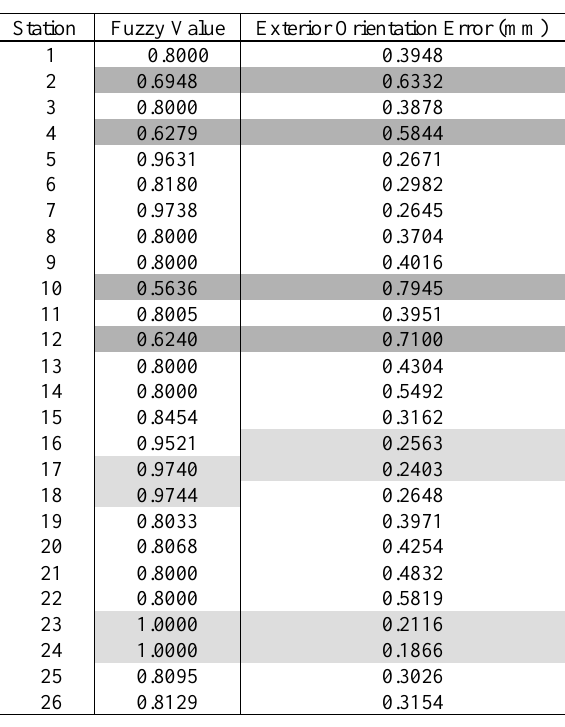
Table 6. Exterior orientation errors and the result of fuzzy value of each station in measuring the plane nose Moreover, the fuzzy computation system was tested on each station and the results are also shown in Table 6. In Table 6, four maximum exterior orientation standard deviation values and four minimum fuzzy values are highlighted with the color of chromatic gray and also four minimum exterior orientation standard deviation values and four maximum fuzzy values are highlighted with the color of pallid gray. As Table 6 shows again, the results for the stations that have maximum/minimum exterior orientation standard deviation values are almost the same as the stations that have minimum/maximum fuzzy values. After omission of stations with low fuzzy values, the bundle adjustment procedure was done with the rest of images.